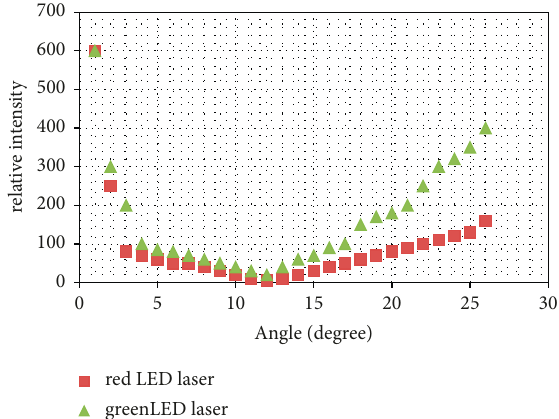
Figure 8: Silver nanoparticles disperse the intensity of green and red laser diode photons in diverse directions [8]. Polarisation has also been examined in a separate investigation. Once the polarised light enters the sample, a polariser blade is placed back into the pattern’s path following polarisation scattering. While the second polariser was rotating at an unusual angle, Excel software was used to represent the final intensity in a variety of wavelengths.